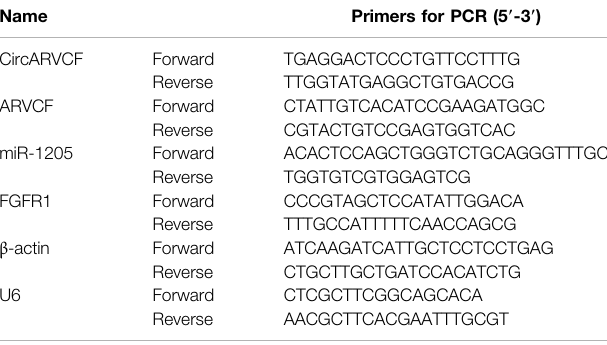
TABLE 1 | Primers sequences used for